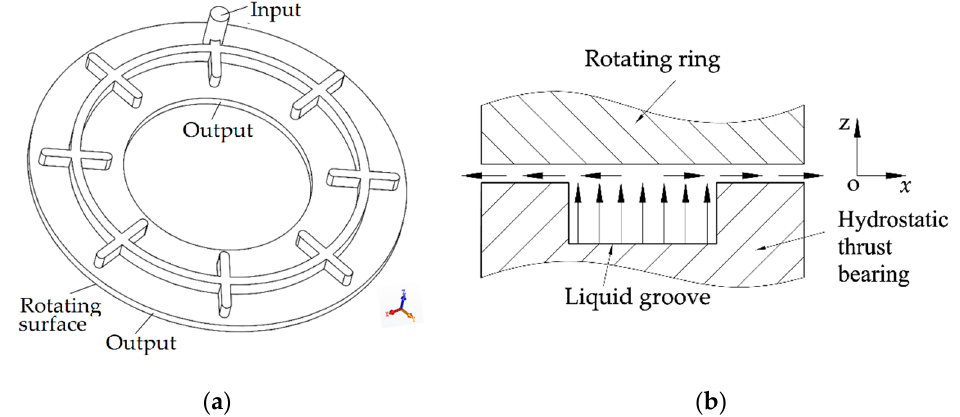
Figure 6. Geometric model: ( a ) water fields in the bearing clearance; ( b ) water flow in the HTB clearance.